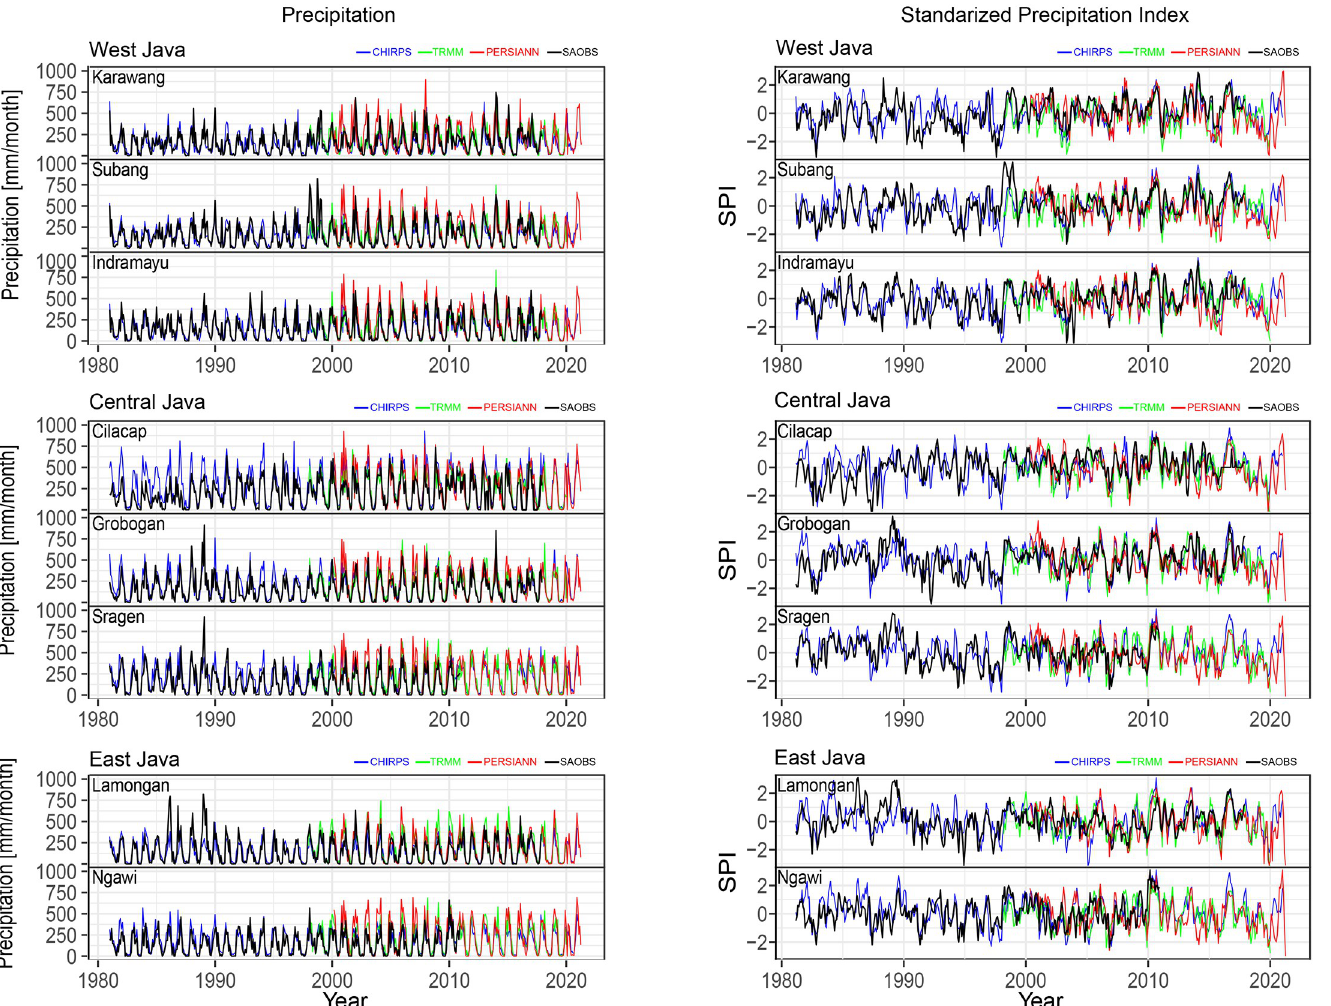
Fig 5. Time series for the monthly precipitation (left) and SPI-3 (right) of the eight largest rice-producing districts in Java grouped by province: West Java (top), Central Java (middle), and East Java (bottom). The monthly precipitation and SPI-3 were determined from CHIRPS (blue), TRMM (green), PERSIANN (red), and SA-OBS